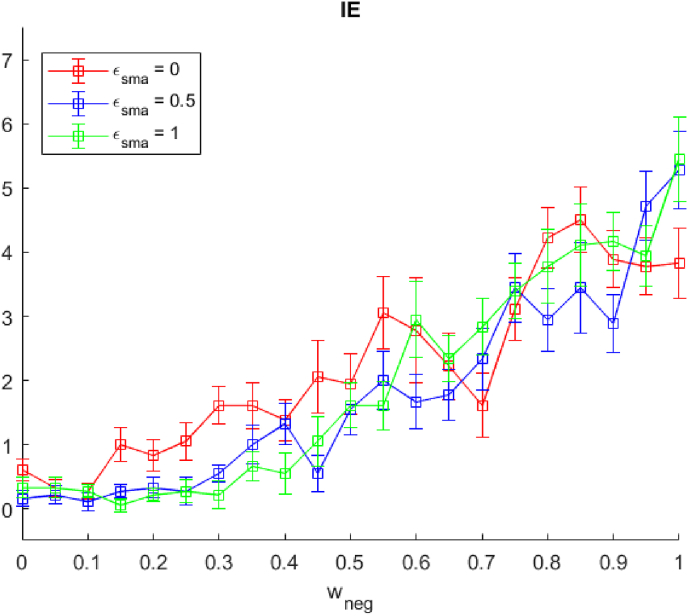
Integration Errors as a function of wneg, for three values of εsma. Recall that wneg determines reward sensitivity in the striatum, with increasing values of wneg corresponding to decreasing reward sensitivity. Decreasing reward sensitivity results in an increased tendency to Integration Errors at all values of εsma. Error bars show one standard error from the mean.